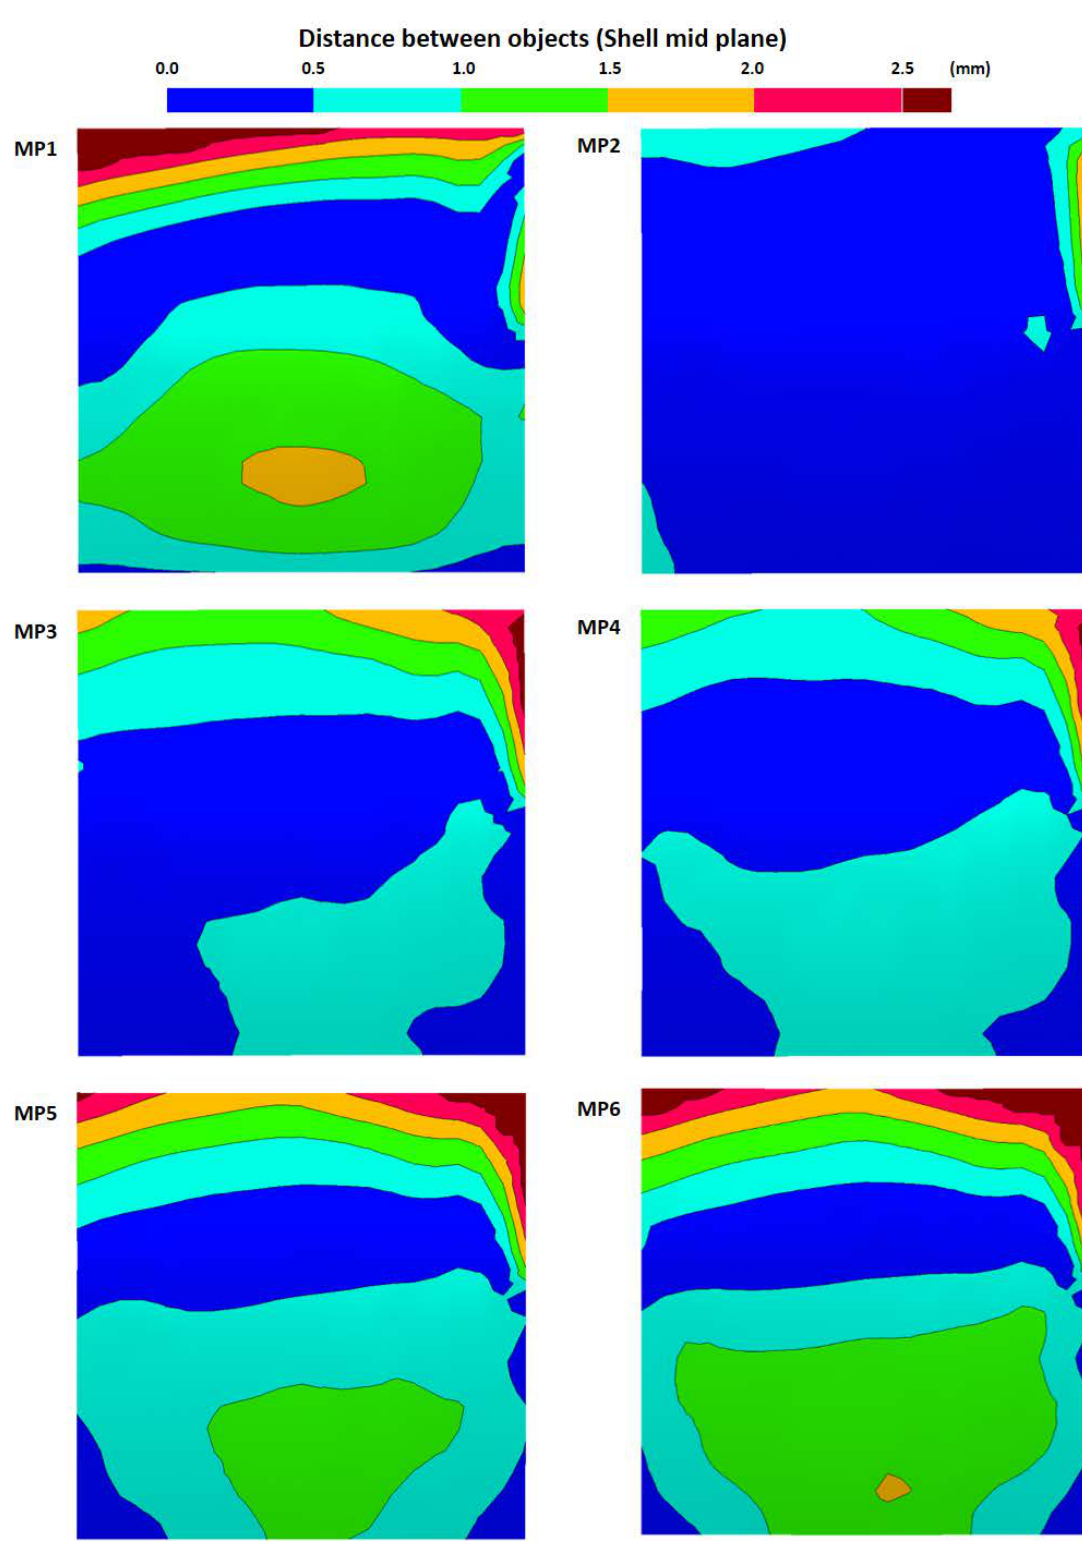
Figure 7. Distance between the real hydroformed piece (Part 1) and simulations employing the six different material properties (MP1 to MP6) summarized in Table 4.